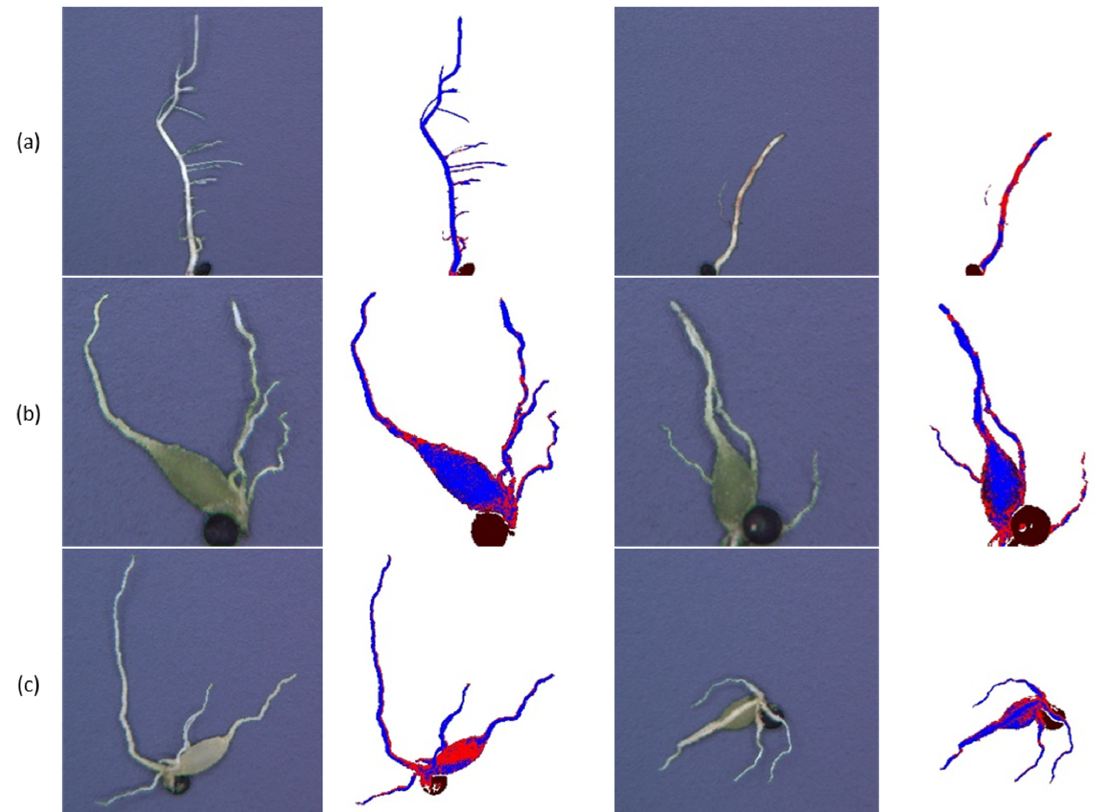
Figure 3. Analysis of diseased tissue caused by F. oxysporum (Foxy III, 14 dpi) using the digital image analysing system of LemnaTec. Left is the control and right is the infected seedlings, each with the original image and the generated colour class image. ( a ) A. officinalis cv. Thielim; ( b ) A. aethiopicus ; ( c ) A. densiflorus . All tested cultivars showed susceptibility to both F. oxysporum isolates (Foxy II and Foxy III). However, there were some differences between the cultivars. For example, A. officinalis cv. Schwetzinger Meisterschuss had a significantly higher susceptibility than A. officinalis cv. Argenteuil (Figure 4, Genotype 15 and 7). The severity of infection ranged from 9% to 42% for Foxy II and 13% to 77% for Foxy III among the tested cultivars (Figure 4).